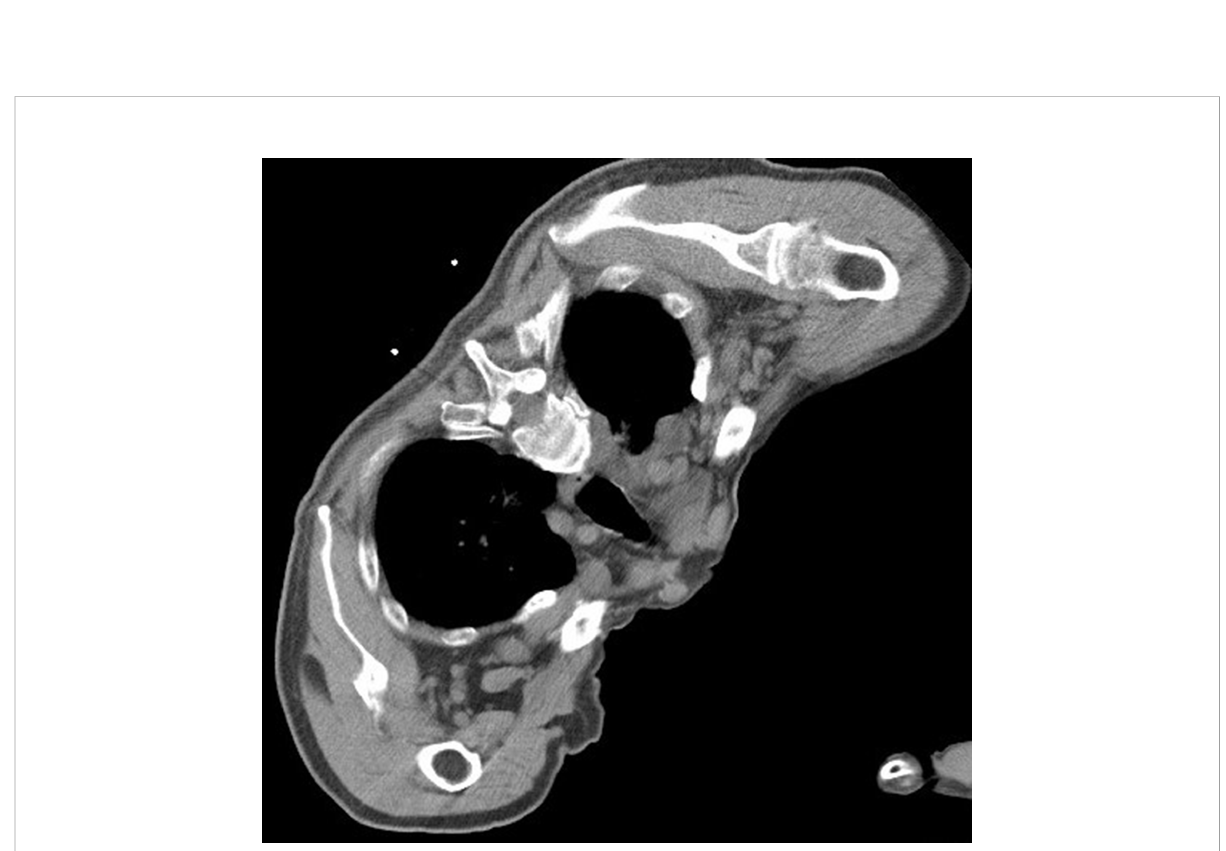
FIGURE 6 Intraoperative scan: the patient ’ s body position was adjusted to isolate the lesion and the adjacent vital organs, and the appropriate amount of normal saline was to form an isolation